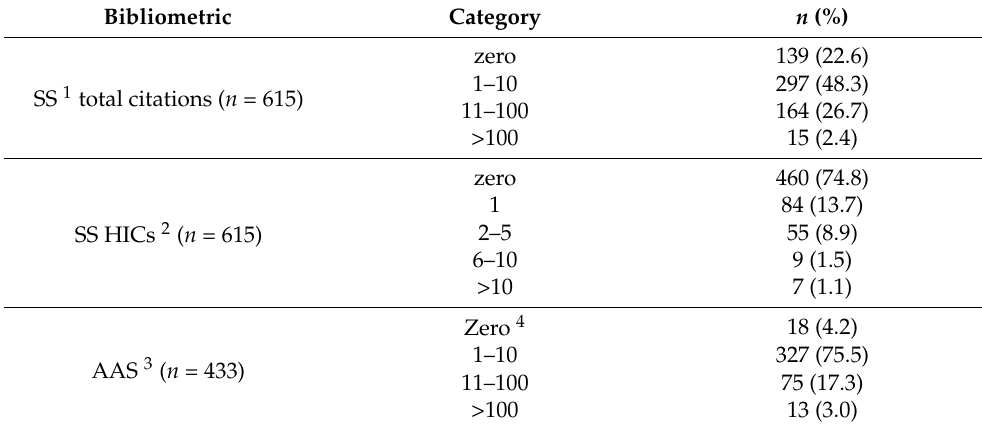
Table 1. Characteristics of the included publications based on different metrics ( N = 618). Bibliometric